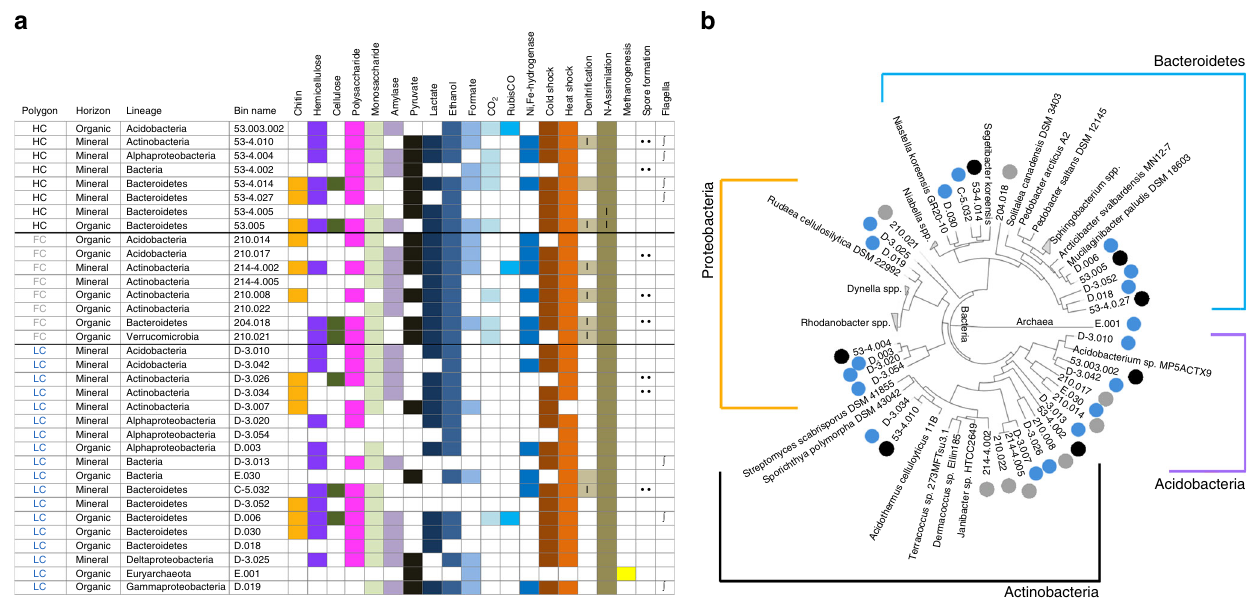
Fig. 4 Thirty-three nearly complete bacterial and one partial archaeal genome are binned from assembled soil metagenomic reads. a Distribution of the metabolic capacity for organic C utilization, fermentation, and respiration identi fi ed in the bacterial genomes reconstructed in this study. Dot sign shows presence of spore forming genes; integral sign denotes presence of fl agellar movement genes; (I) designates incomplete pathways. b Maximum likelihood phylogenetic tree was constructed by using 49 highly conserved COG families from publicly available Our novel fi ndings go beyond generalizations to illustrate which speci fi c C decomposition pathways (e.g., genes for cellulose and chitin degradation; Fig. 4a) are present in the soil micro- biome and the metabolic capacity of speci fi c populations (gen- omes) from the site and how those data are correlated to gas fl ux measurements. In particular, there were contrasting carbon relative abundance of genes for degradation of more complex simple carbohydrates and fermentation in the LC polygons. We gen cycle. For example, higher levels of genes for nitrogen fi xation were detected in LC polygons and higher levels of genes for between low levels of genes for N 2 O production across the polygons that corresponded to low measured N 2 O fl ux at the Barrow site.